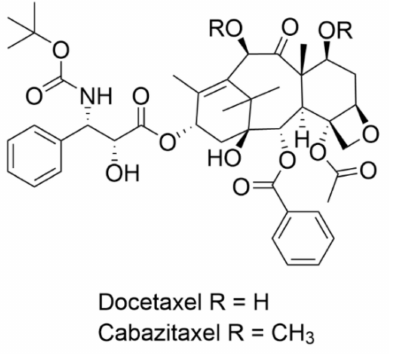
Figure 2. Chemical structure of docetaxel and